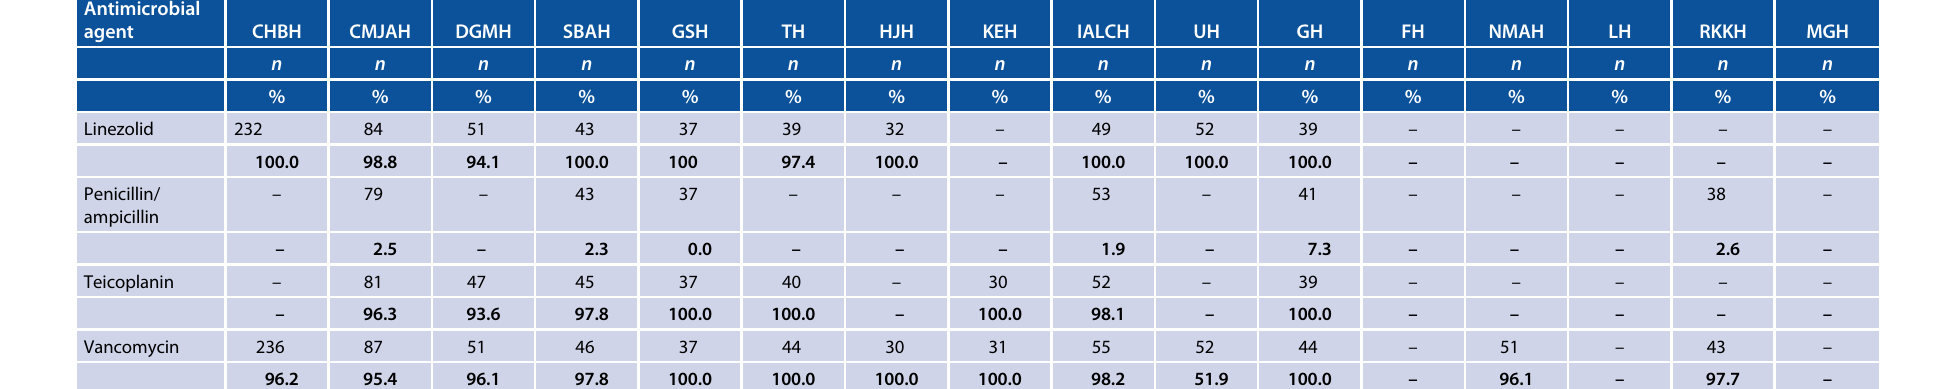
Table 11: Number and percentage of susceptible Enterococcus faecium isolates per antimicrobial agent from 16 sentinel hospitals across South Africa, January 1, 2016 to December 31, 2016 Antimicrobial agent